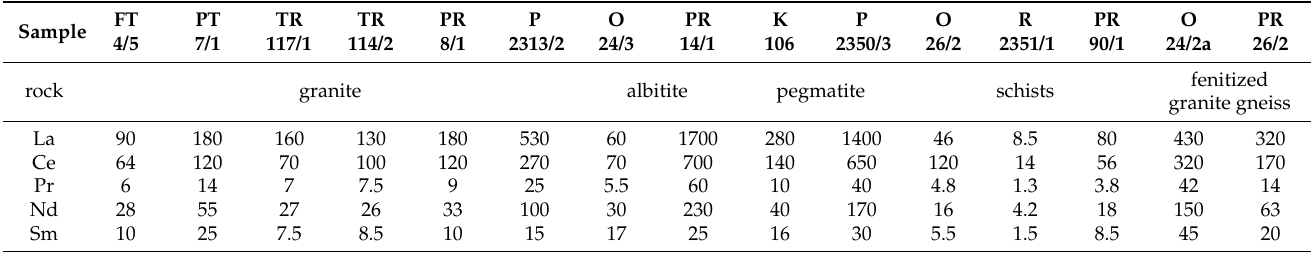
Table 4. REE and rare-metal contents in the rocks of the Tommot ore field (in ppm).